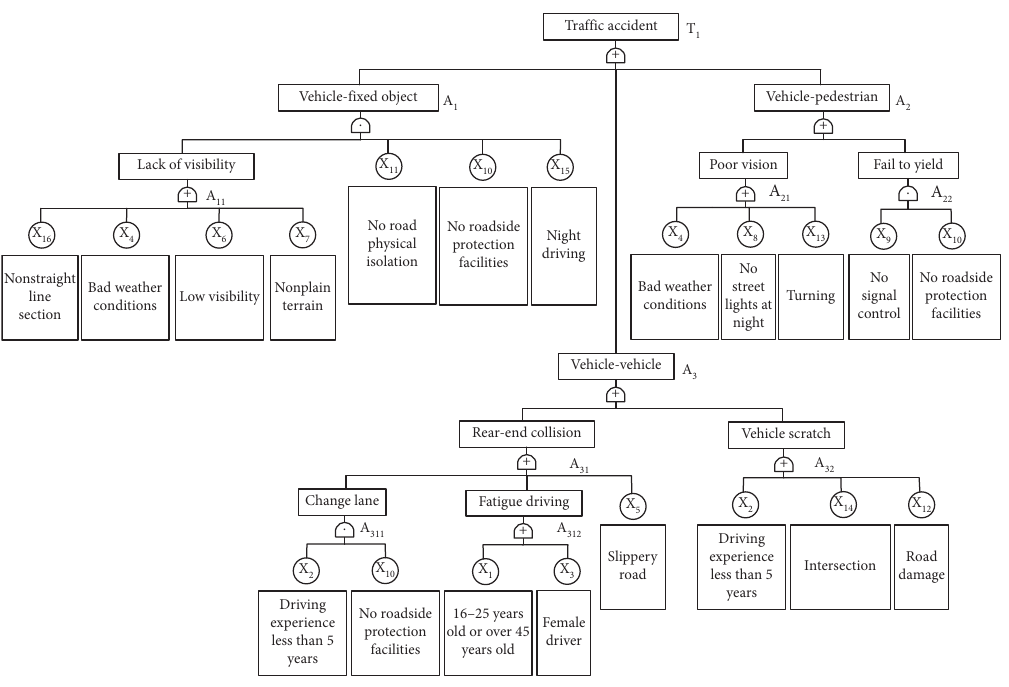
Figure 2: Fault tree of traffic accidents in urban bus operation.